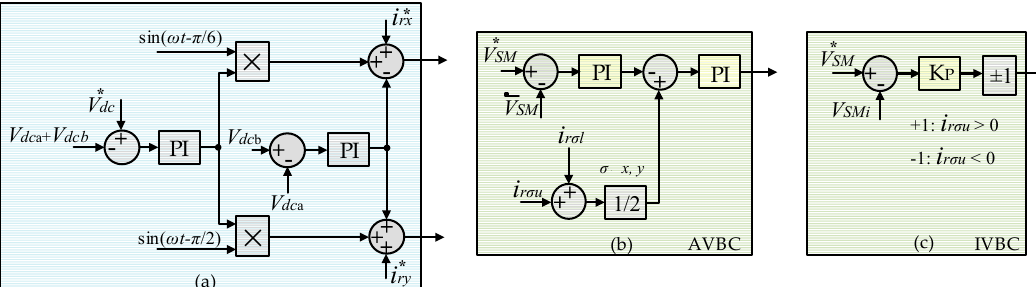
Figure 5. RPC based on half-bridge MMC control blocks: ( a ) DC-link voltage control; ( b ) averaging voltage balancing control (AVBC); ( c ) individual voltage balancing control (IVBC).